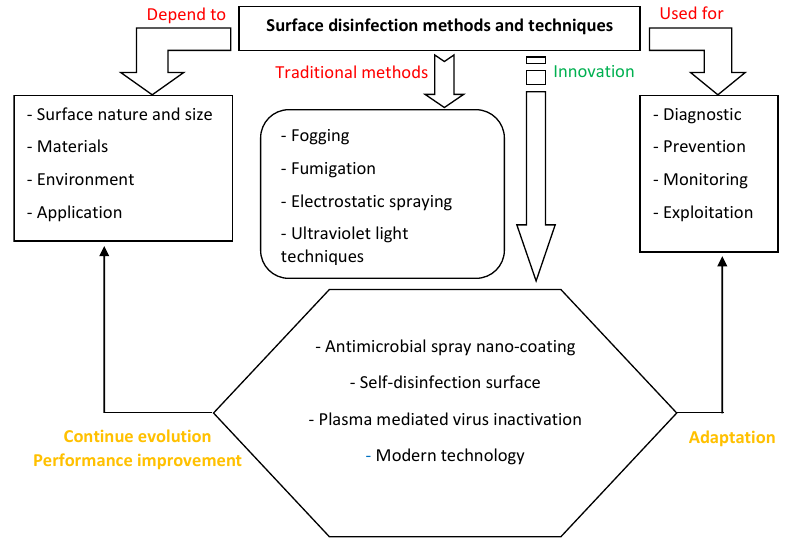
Figure 5. Newmodelofsurfacedisinfectionmethods, Figure 5. New model of surface disinfection methods, techniques and possible interactions and evolution.